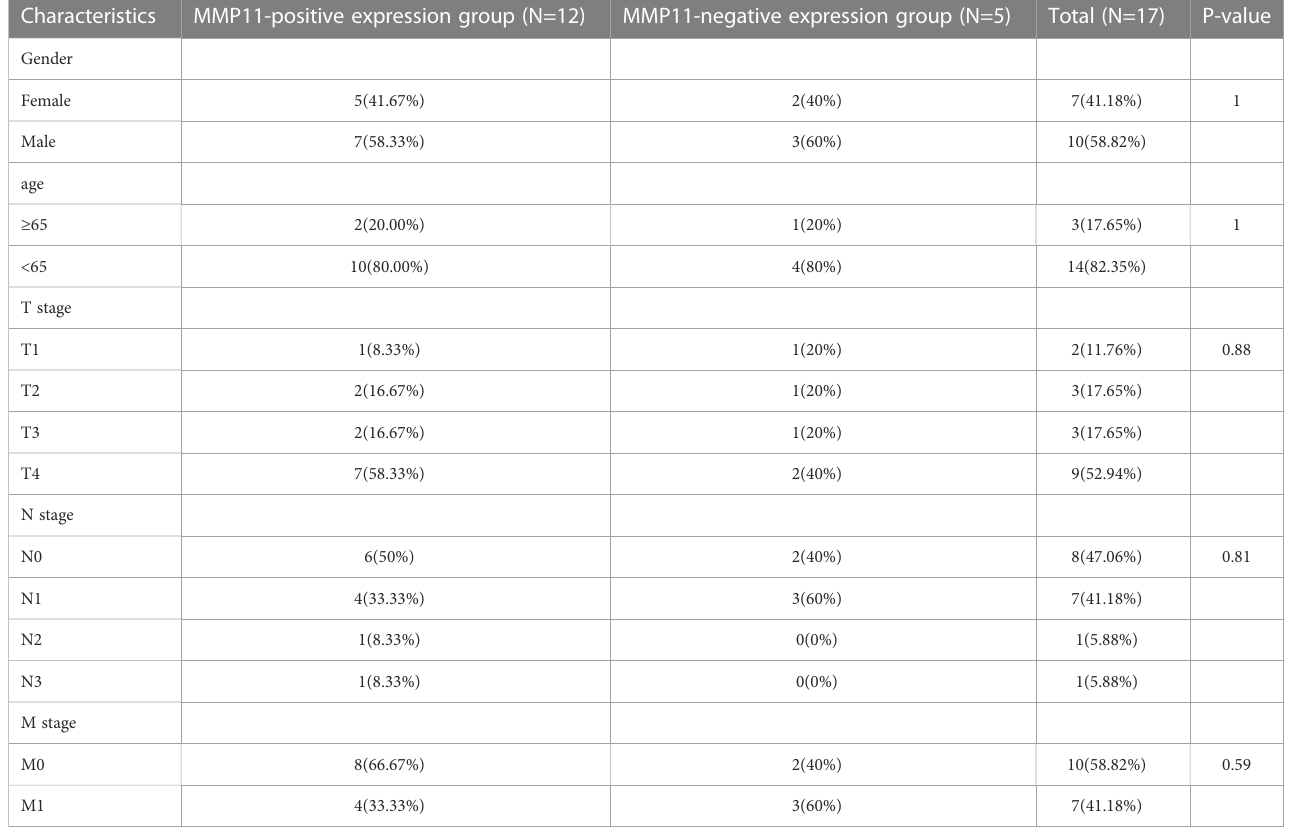
TABLE 1 Baseline clinical data of 17 cases of EGFR-mutant lung adenocarcinoma.